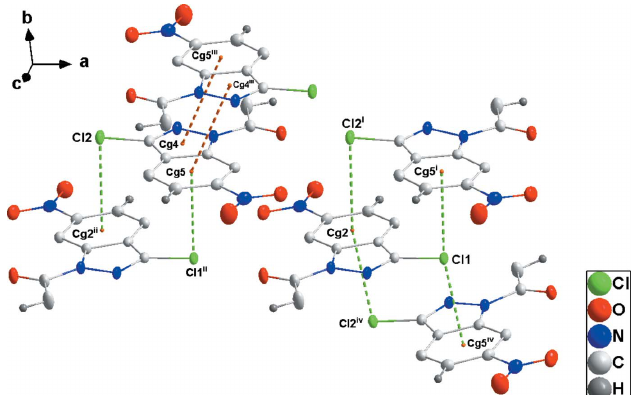
Figure 2 Detail of the (cid:2) – (cid:2) stacking (orange dashed lines) and C—Cl (cid:2)(cid:2)(cid:2) (cid:2) (ring) (green dashed lines) interactions [symmetry codes: (i) x + 1, y , z ; (ii) x (cid:5) 1, y , z ; (iii) (cid:5) x + 1, (cid:5) y + 1, (cid:5) z + 1; (iv) x + 1, (cid:5) y + 1 C7 ring); Cg 4 = centroid (C10/C11/C16/N4/N5 ring); Cg 5 = centroid(C11– C16 ring).